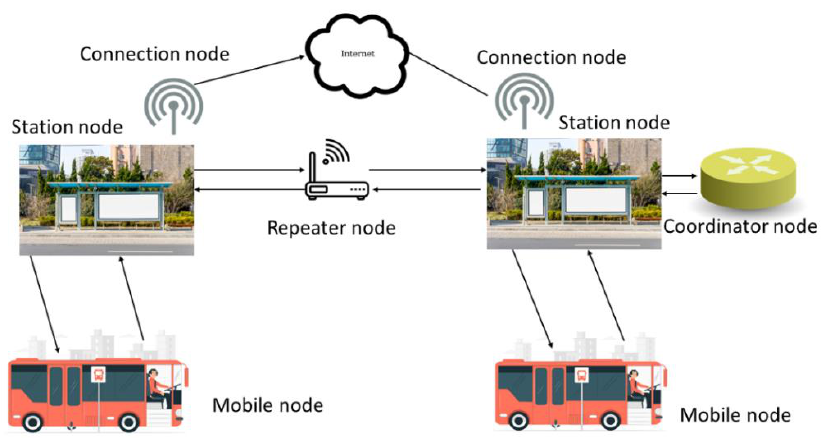
Figure 3. Network architecture for two stations.